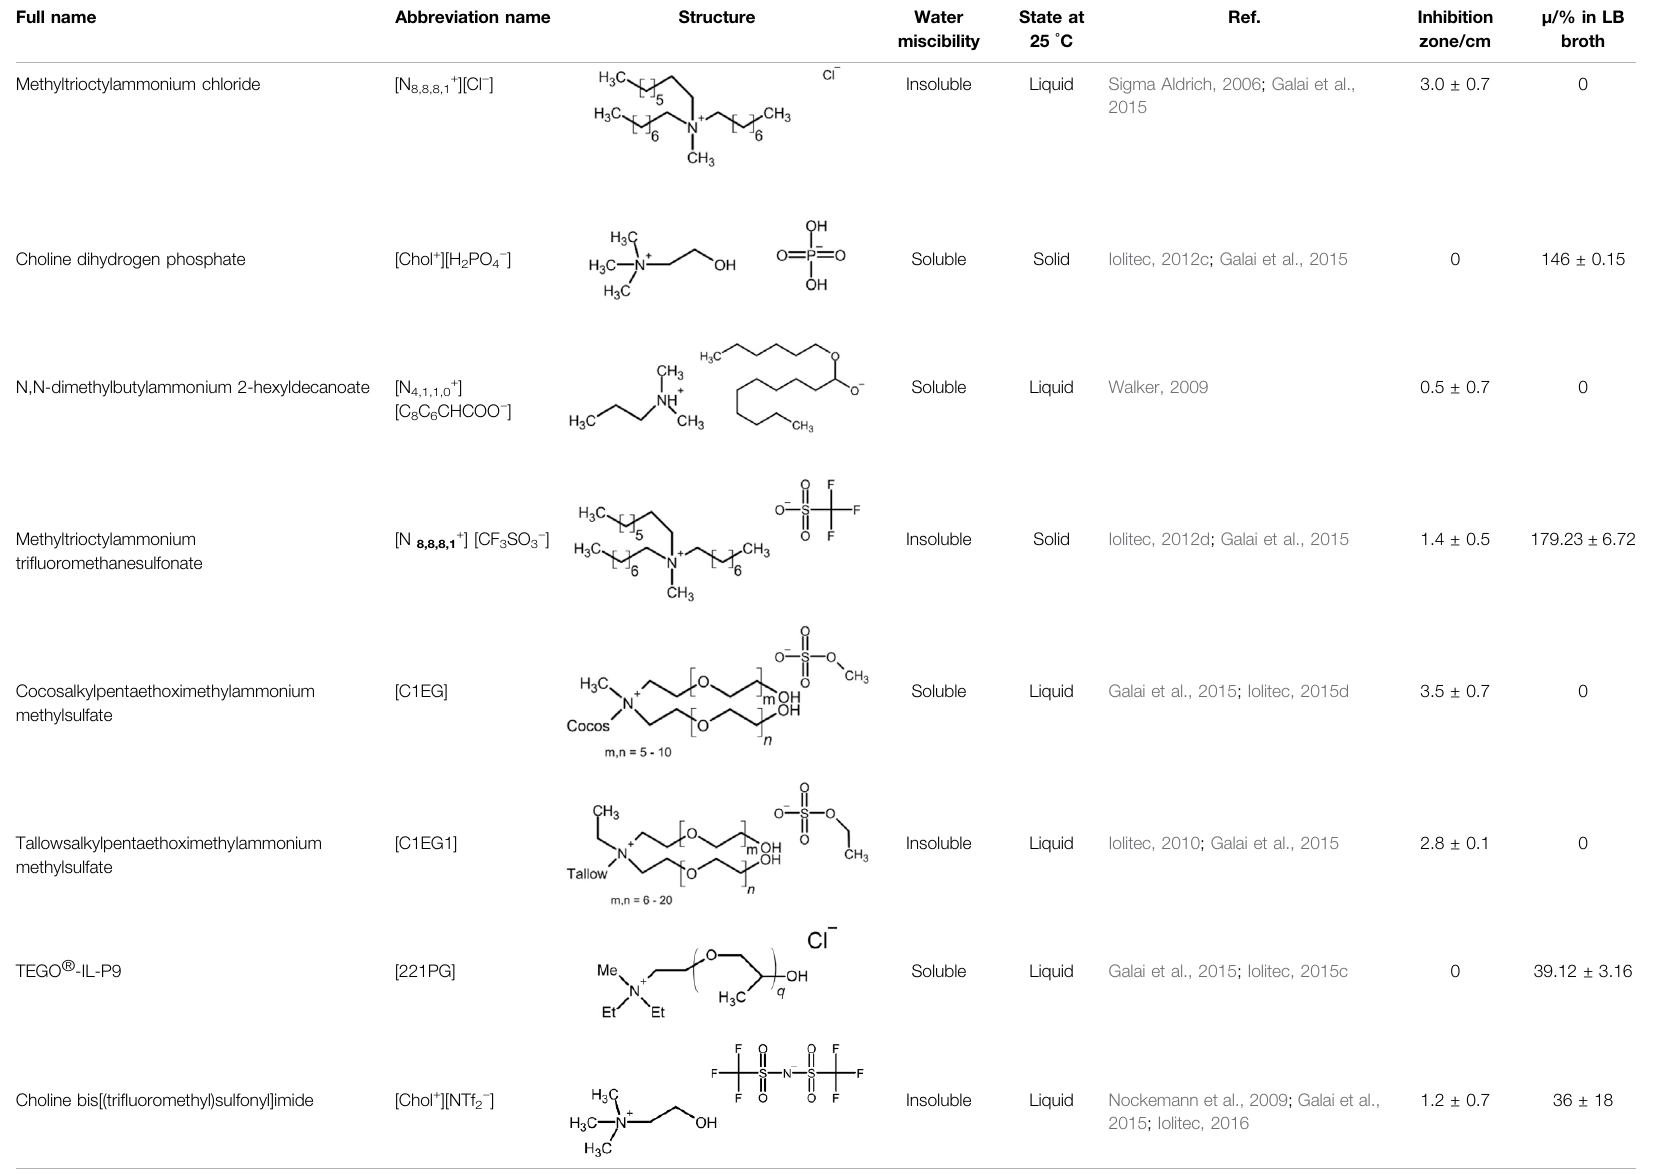
TABLE 7 | Ammonium-based ionic